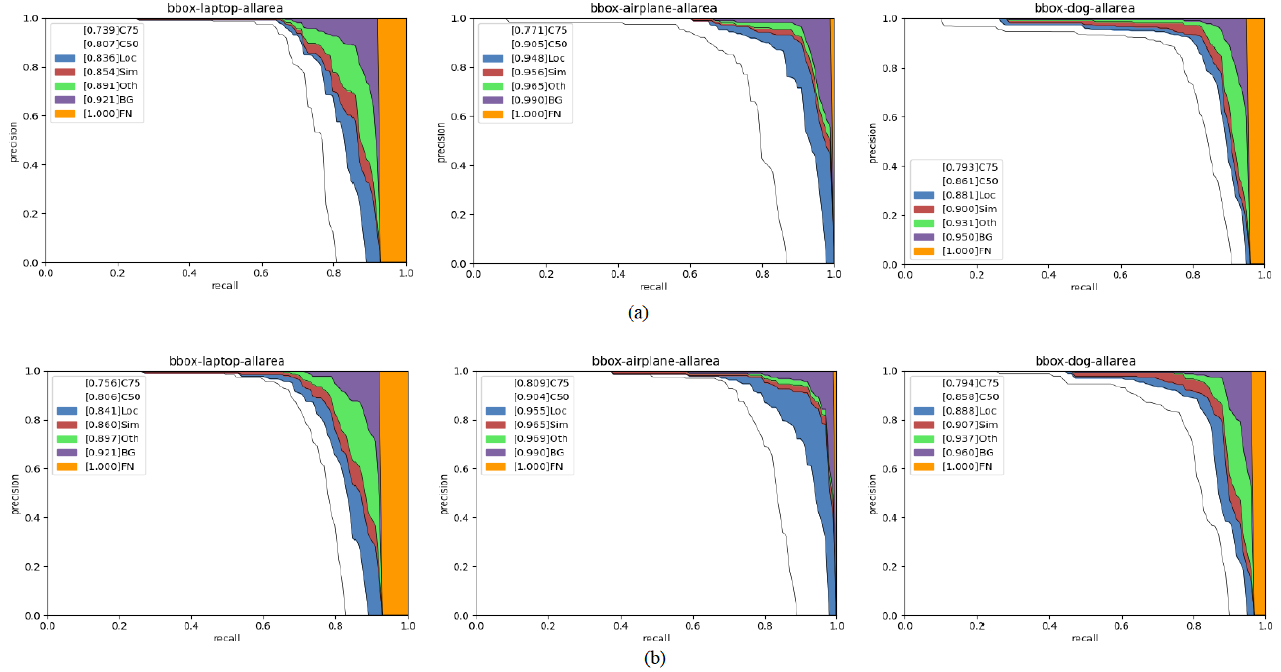
Figure 4. Comparison of the ROC of BFT with FPN. The upper layer ( a ) of figure is the ROC of ATSS with FPN, and the lower layer ( b ) of figure is the ROC of ATSS with BFT. From left to right are the ROCs for laptops, airplanes, and dogs.